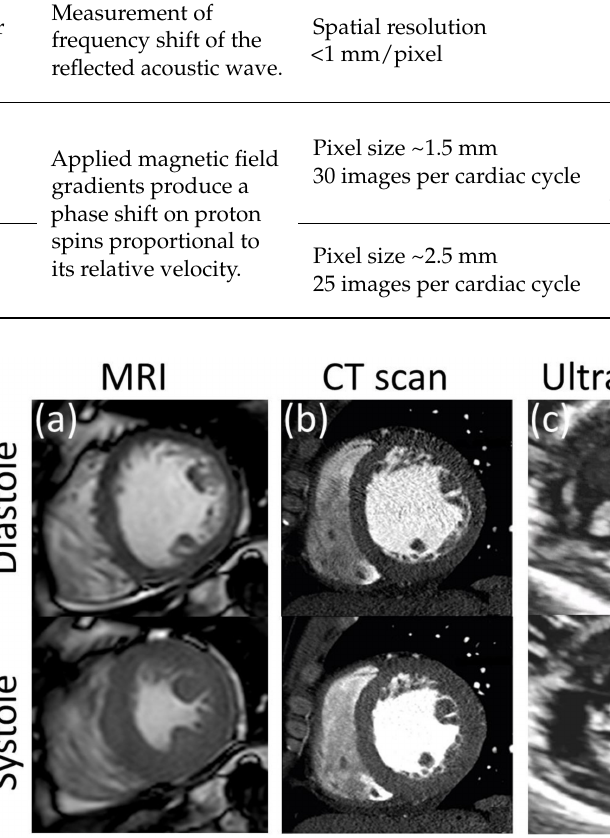
Figure 7. Resolution comparison of left ventricular myocardium at diastole and systole with clinical grade ( a ) MRI, ( b ) CT (Reprinted/adapted with permission from Ref. [158], 2019, Korean Society of Echocardiography, open access), and ( c ) 2D